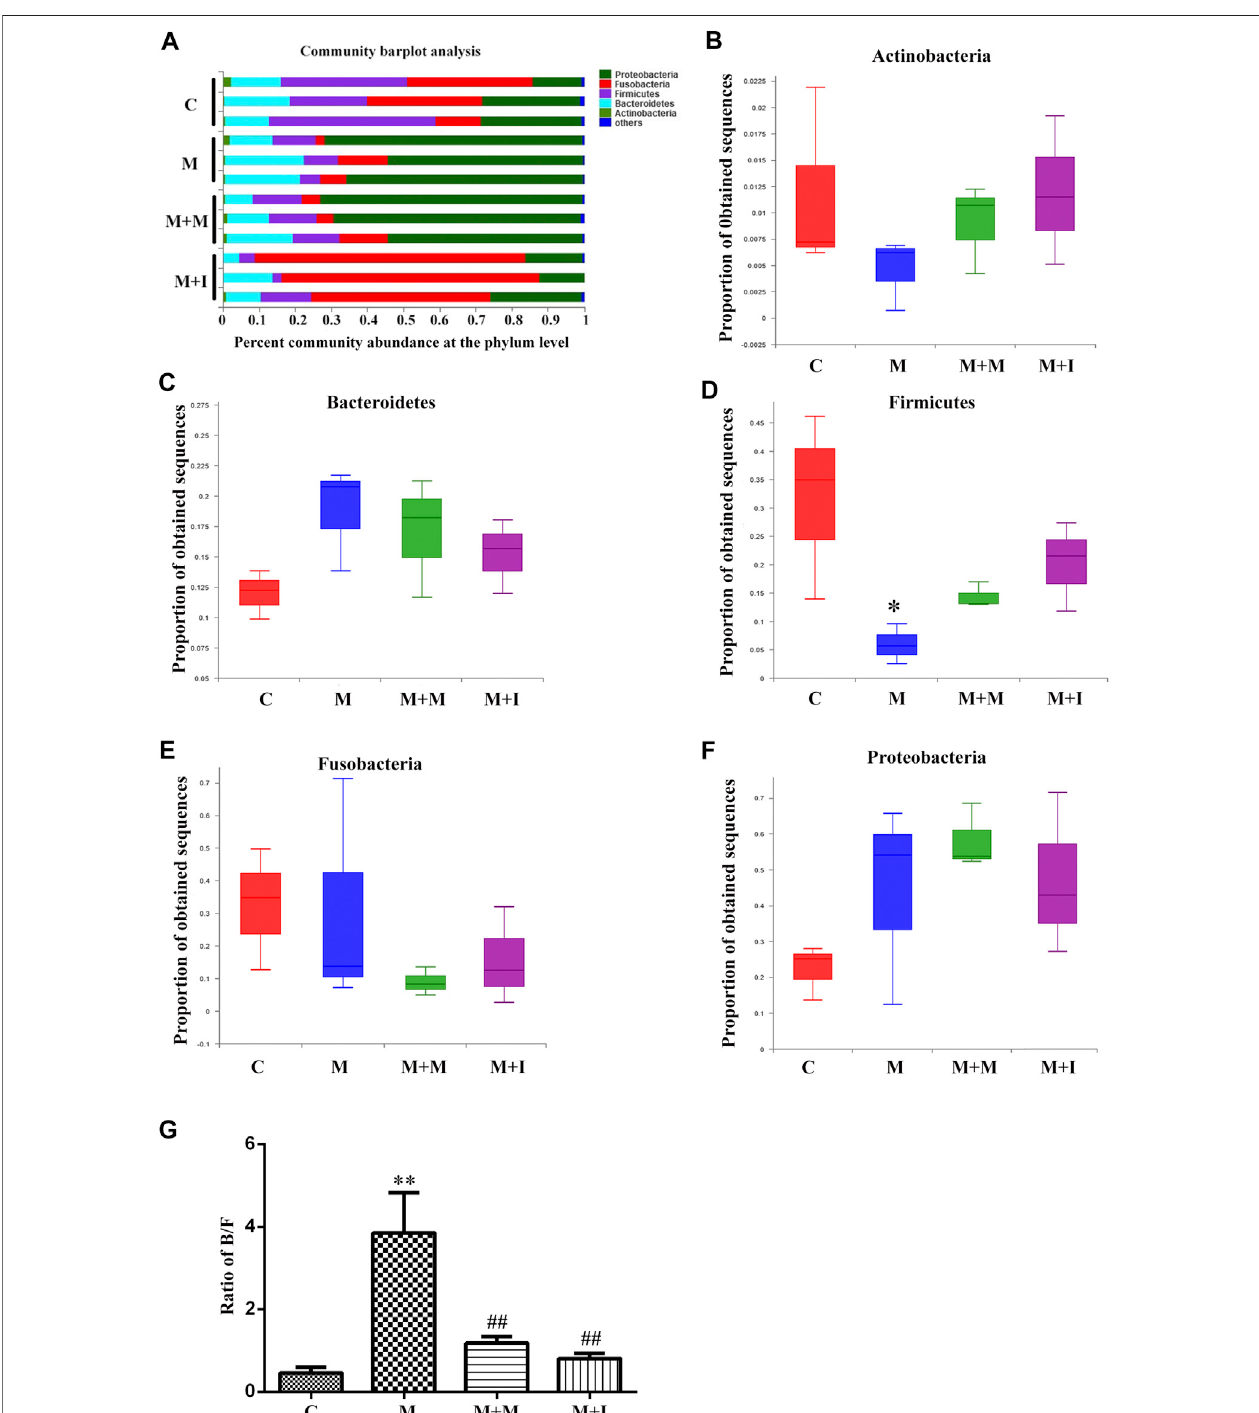
FIGURE 6 | Comparison of species composition among the fecal microbiota of the C, M, M + M, and M + I groups at the phylum level. (A) Relative abundances of thephylapresentinsamplesfromthefourgroups.Percentabundanceof (B) Actinobacteria (C) Bacteroidetes (D) Firmicutes (E) Fusobacteria,and (F) Proteobacteriaat thephylumlevelamongthefourgroups. (G) TheBacteroidetes/Firmicutes(B/F)ratioofthefourgroups.* p < 0.05,** p < 0.01 vs theCgroup; # p < 0.05, ## p < 0.01 vs the M group. C : control group; M: morphine group; M + M: morphine + methadone group; M + I: morphine + isorhynchophylline group.